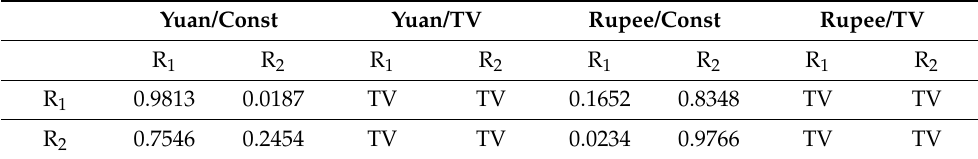
Table 7. Transition Probabilities of MRSR